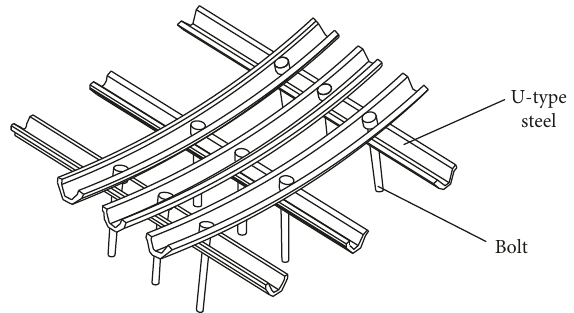
Figure 6: U-type steel inverted arch supplemented by bolt, reproduced from Peng et al. [13] (under the Creative Commons Attribution License/public